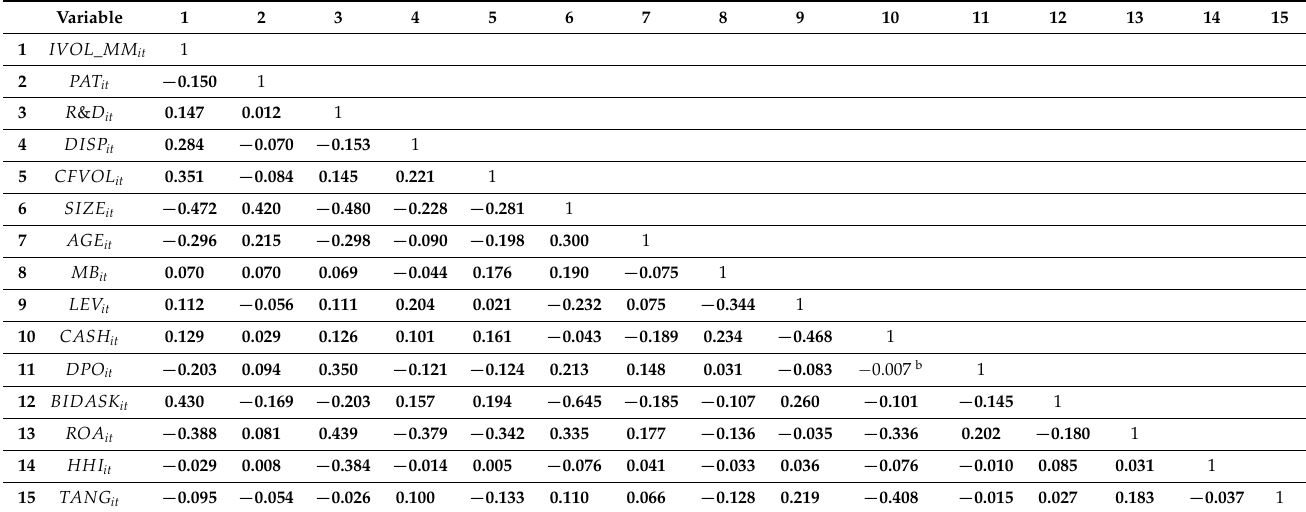
Table 4. Pearson correlations between the variables included in the analysis. The sample period was from 1982 to 2015. The correlations in bold are at least significant at the 1% level, and a and b denote correlations significant at the 10% and 5% level, respectively (the other measures of IVOL were removed due to space limitations; the full correlation matrix is available upon request).